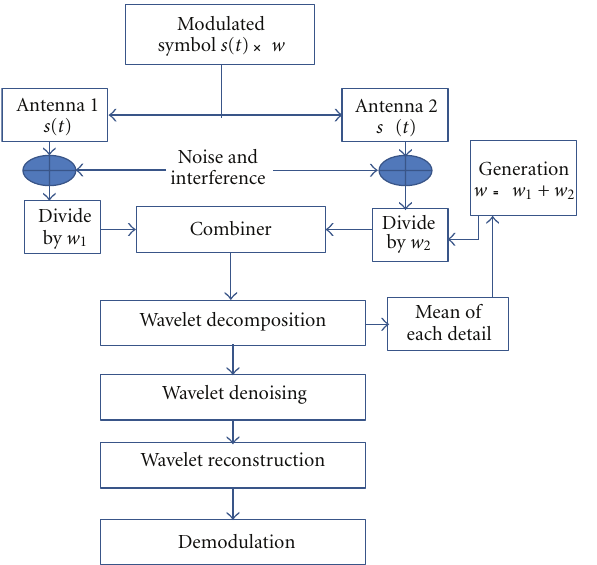
Figure 10: Wavelet denoising in antenna diversity.